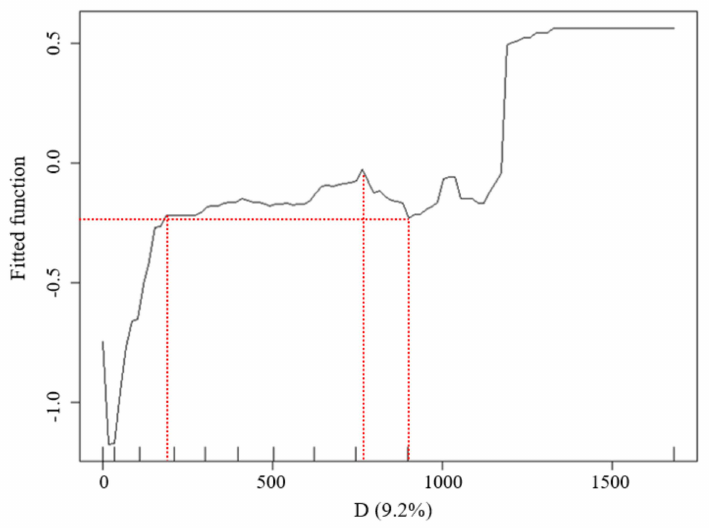
Figure 10. Contribution ratios of each factor to the LST of the waterfront green space in Width-II river corridors.